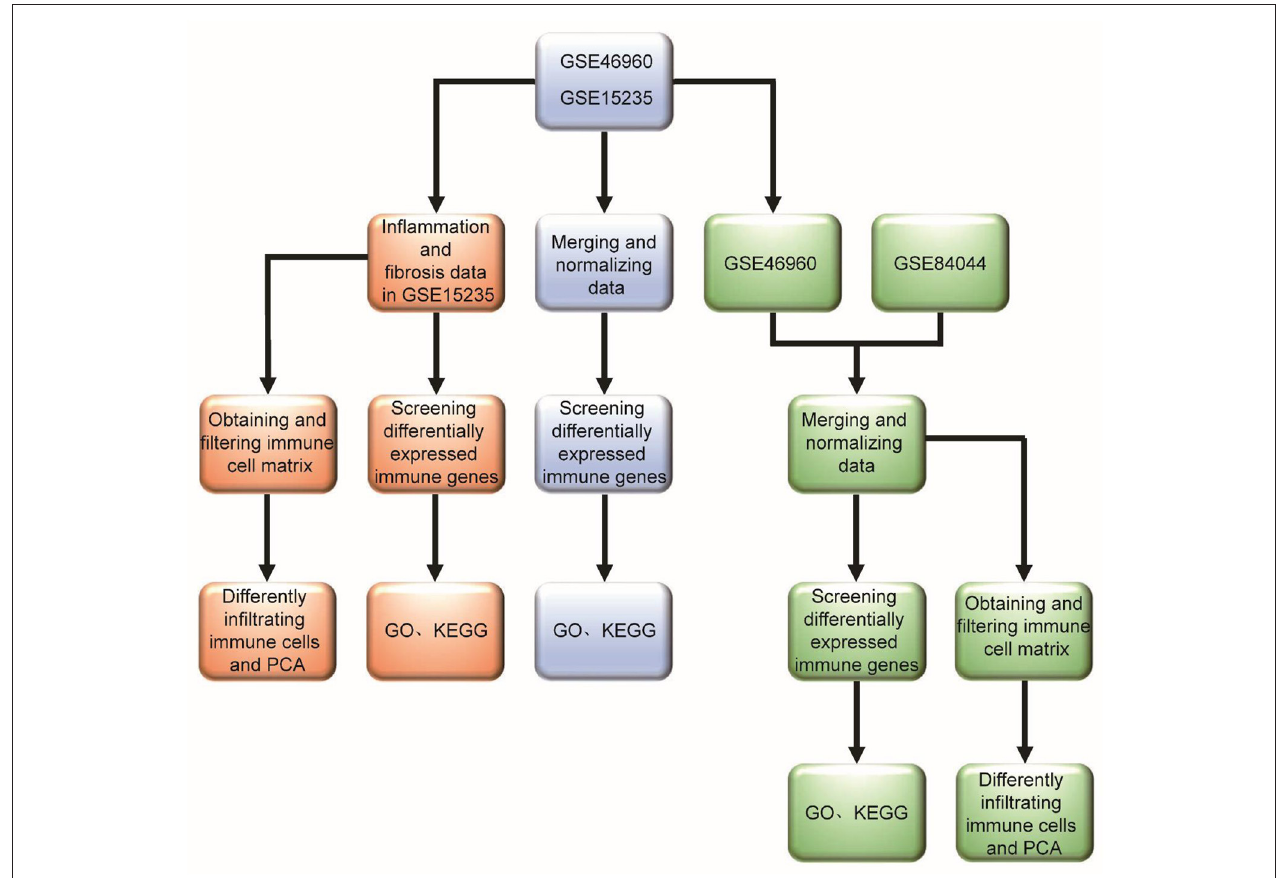
FIGURE 1 | Research flowchart of this